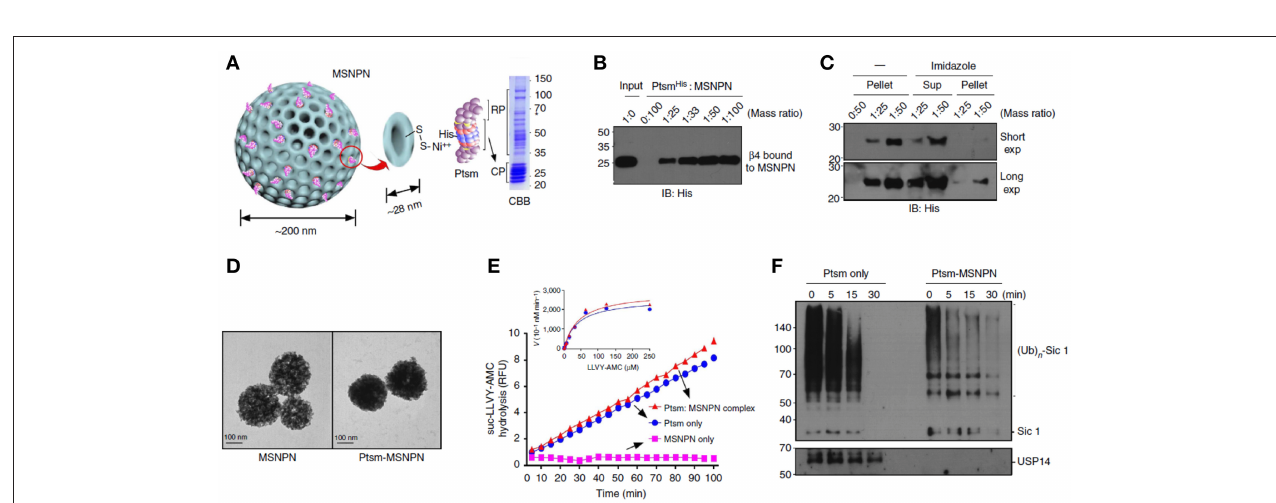
FIGURE 3 | Responsive MSNs based protein delivery system for cancer therapy. Schematic drawing (A) showed the synthesis of biodegradable diselenide-bridged MSNs [TEM images in (B) ] with dual-responsive and cancer cell membrane mimetic surface modification was used to deliver RNase A into cancer cells (C) and inhibit tumor growth in vivo (D) . Reproduced with permission from Shao et al. (2018), The Wiley-VCH.